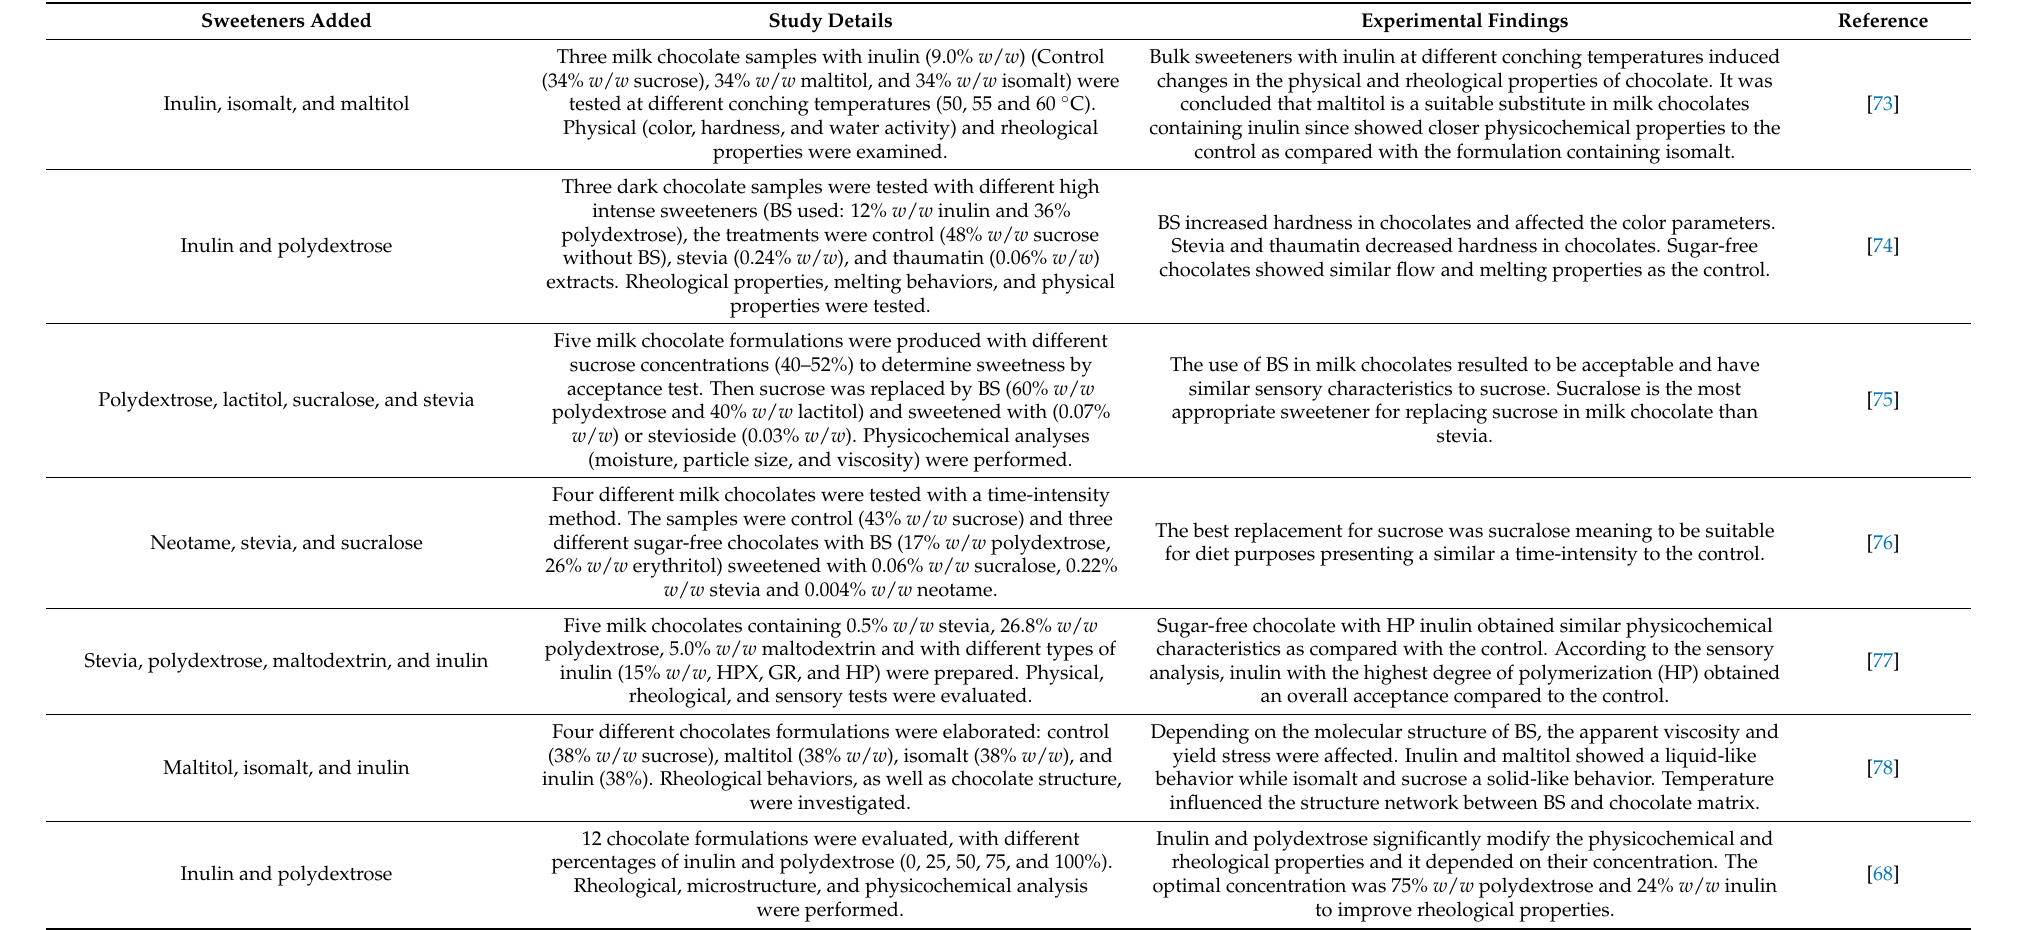
Table 3. Effect of sugar replacement by sweeteners on the physicochemical and sensory properties of chocolate